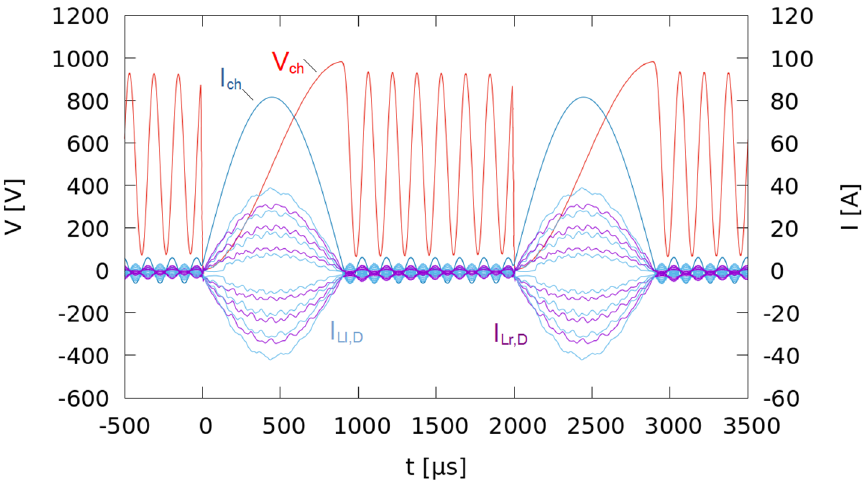
Figure 18. Distribution of the charging current along the charging path according to the position in the generator for an on-time of the solid-state switches of 22 µs. The charging currents I Ll,D through the coils of the left four current-compensated chokes are shown in light-blue colour, and the charging currents I Lr,D through the coils of the right three current-compensated chokes in violet colour. Thereby, the current decays stepwise from the centre towards both ends of the generator. V ch and I ch denote the charging voltage and the charging current at the generator’s input terminal, respectively.